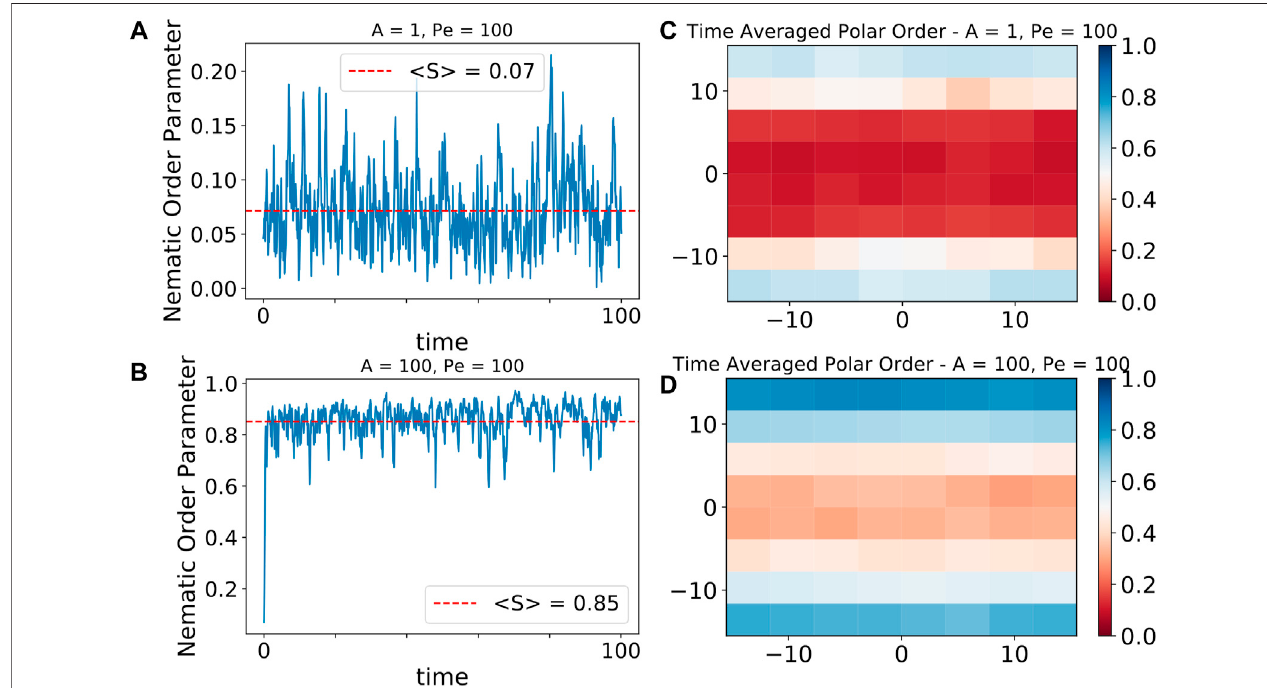
FIGURE 6 | Elastic interactions promote global nematic order and local polar order. (A) Global nematic order, measuring the overall alignment of the particles ’ dipoleaxes, vs .timeforloweffectiveelasticinteractionandhighactivity.Averageglobalnematicorderisnegligiblefortheseparameters. (B) Globalnematicorder vs .time for high effective elastic interaction and high activity. The system quickly gains apersistentglobal nematic order parameter near unity because thechains align parallelto each other. (C) Spatial distribution of time averaged polar order, where grid size is 3.75 σ × 3.75 σ , measuring the overall orientation of motility for the particles, for a characteristicrunatloweffectiveelasticinteractionandhighactivity. Particlesaccumulateattheboundaryandexhibitpolarorderalongthatboundary.Thisorderrapidly decays away from the boundary and there is virtually no polar order observed in the bulk. (D) Spatial distribution of time averaged polar order, where grid size is 3.75 σ × 3.75 σ , for a characteristic run at high effective elastic interaction and high activity. A polar order near unity is observed at the boundary and persists into the bulk where near the middle of the channel | p | ≈